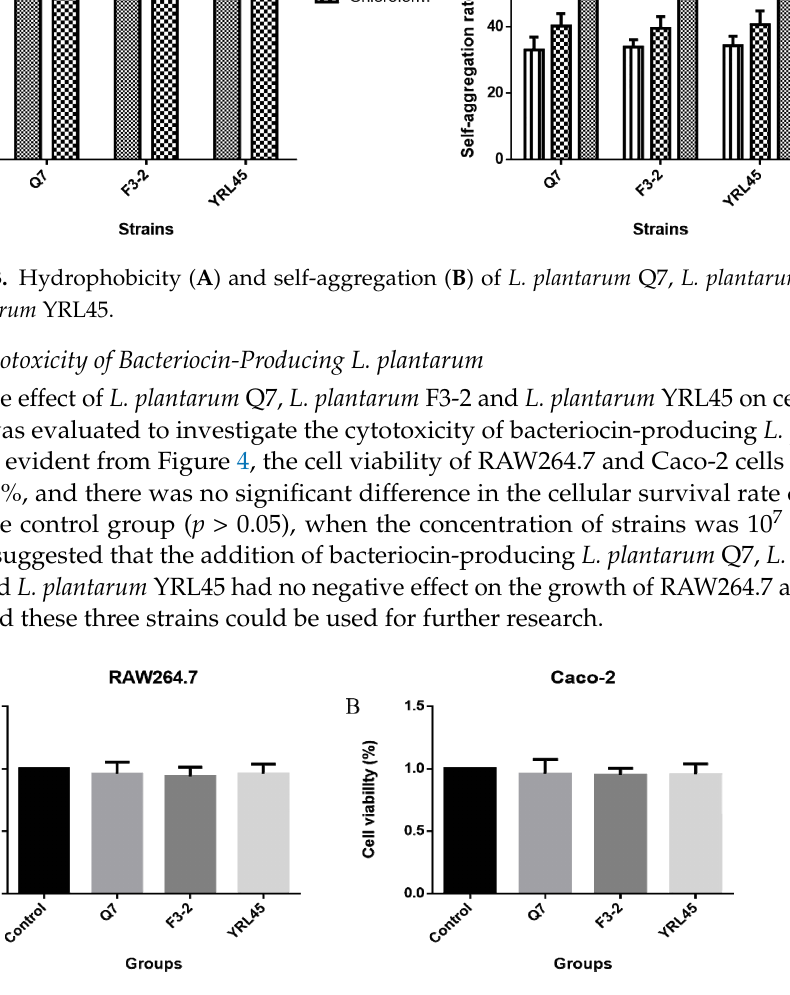
Caco-2 ( B ) cells Caco-2 ( B ) cells viability.